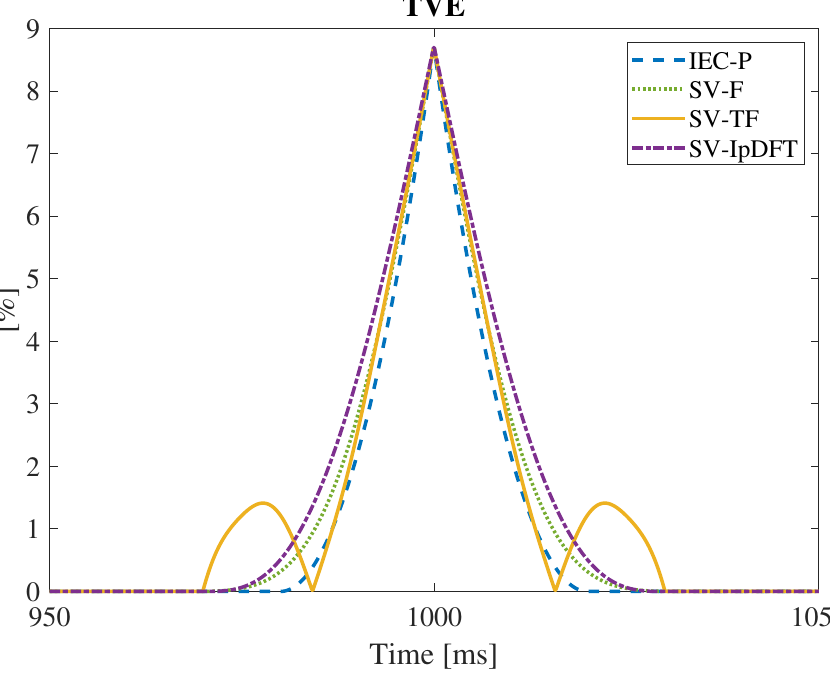
Figure 23. TVE in the presence of a − 10 ◦ phase